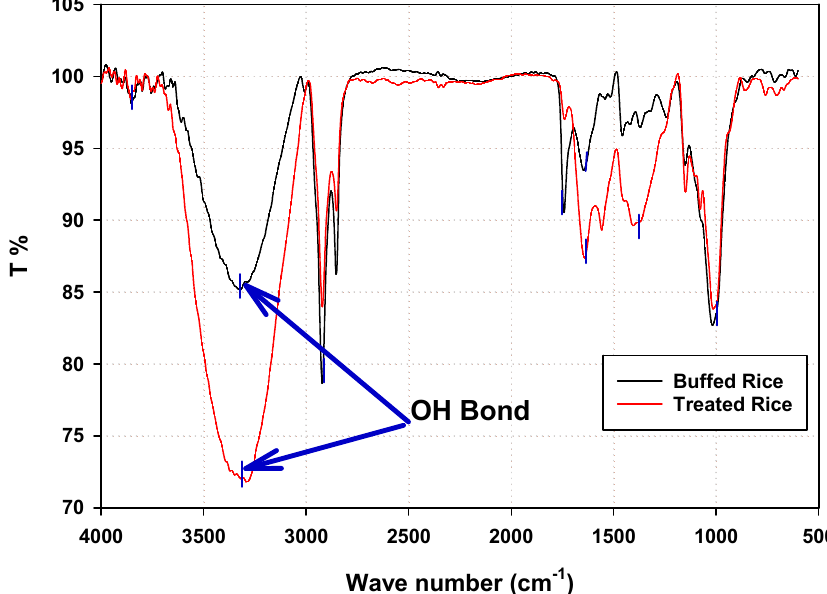
Figure 10. FTIR spectra of fresh puffed rice samples and samples treated with sodium hydroxide.